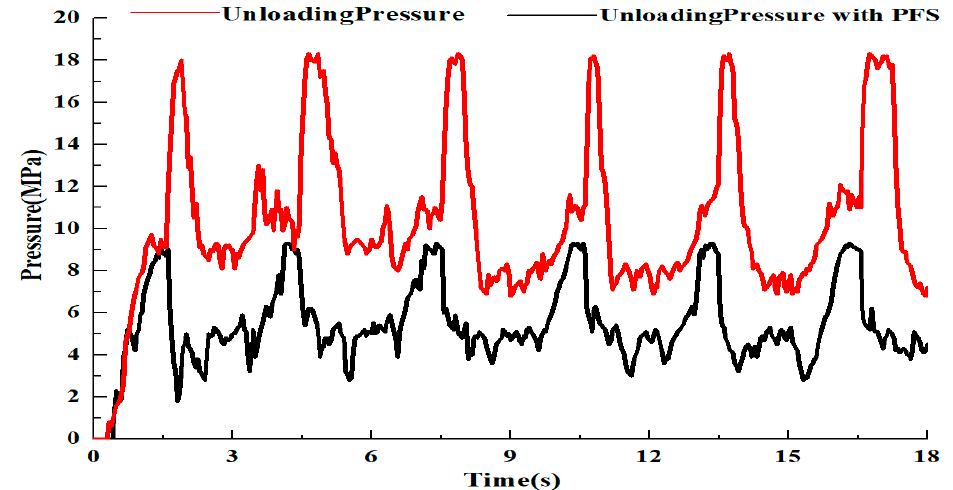
Figure 8. Unloading pressure of the hydraulic press with the energy-saving system and the traditional hydraulic press during fast forging.